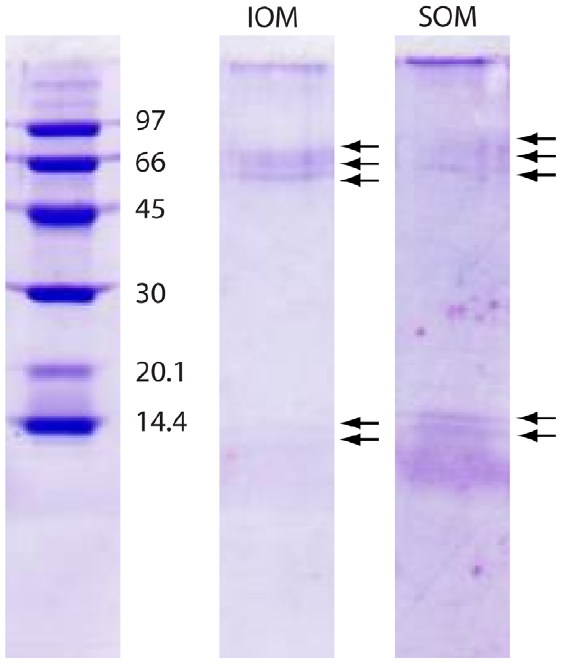
Figure 3. OM characterization. SDS-polyacrylamide gels electro- phoresis of intra-skeletal insoluble (IOM) and soluble (SOM) organic matrix extracted from the Balanophyllia europaea skeleton. In the first lane the markers are reported. The arrows indicate the major proteic bands.